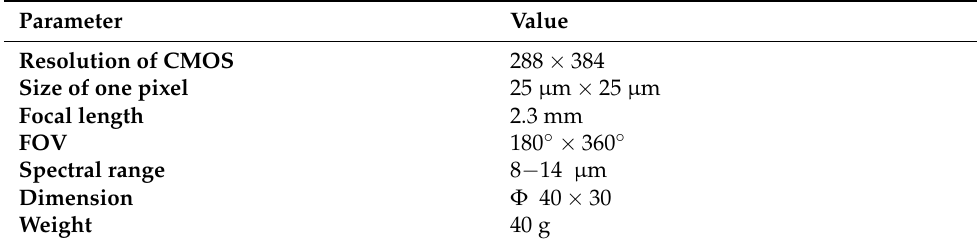
Table 1. Specifications of the infrared camera.